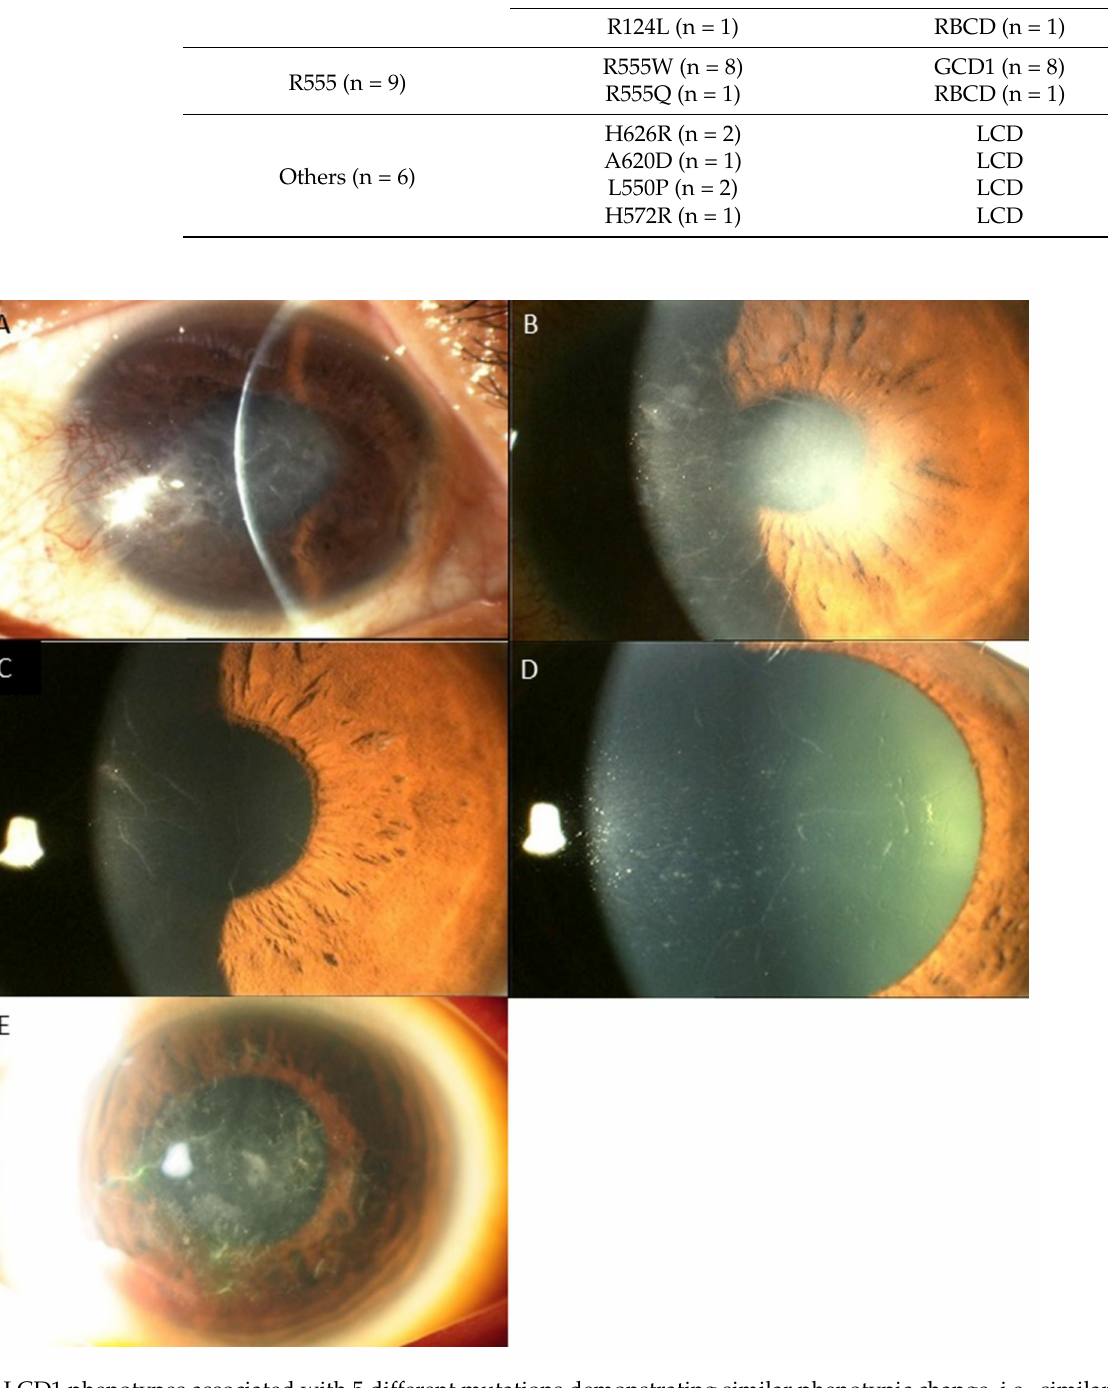
Figure 4. LCD1 phenotypes associated with 5 different mutations demonstrating similar phenotypic change, i.e., similar refractive lines, dots and subepithelial haze of varying severity. ( A ): H572R , ( B ): R124C , ( C ): H626R , ( D ): L550P , ( E ): A620D